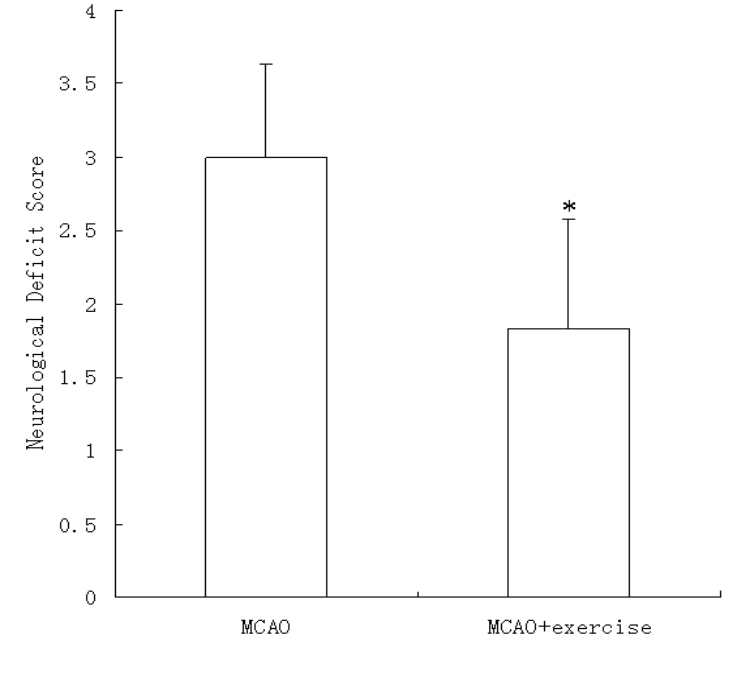
Figure 1. Neurological deficits at 48 h after reperfusion with or without prior exercise. MCAO caused neurological deficits that were not observed in sham surgery animals. Three weeks of exercise prior to MCAO significantly decreased neurological deficits. Data represent median ± interquartile range. *P < 0.01 relative to